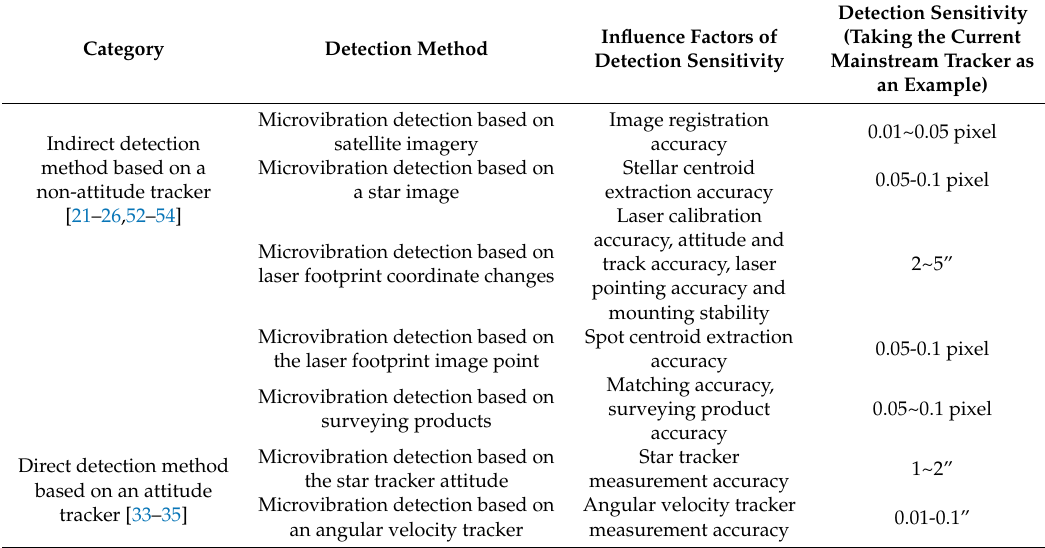
Table 3. Detection sensitivity